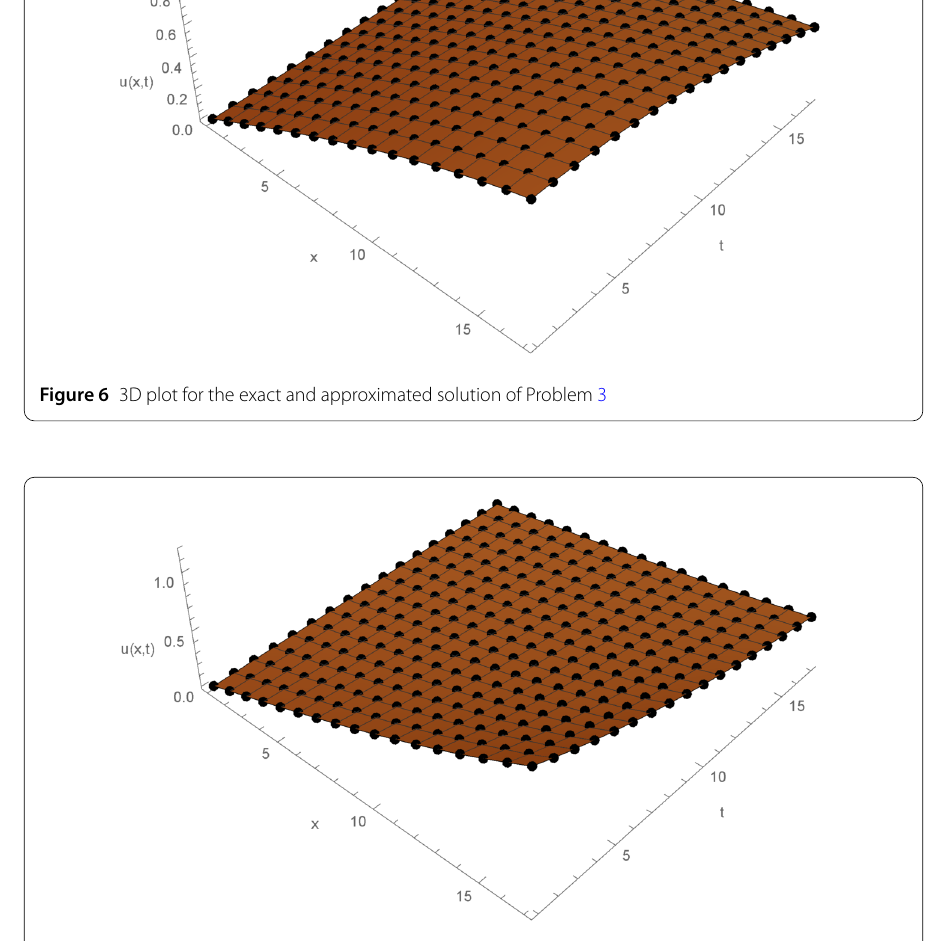
Figure 7 3D plot for the exact and approximated solution of Problem